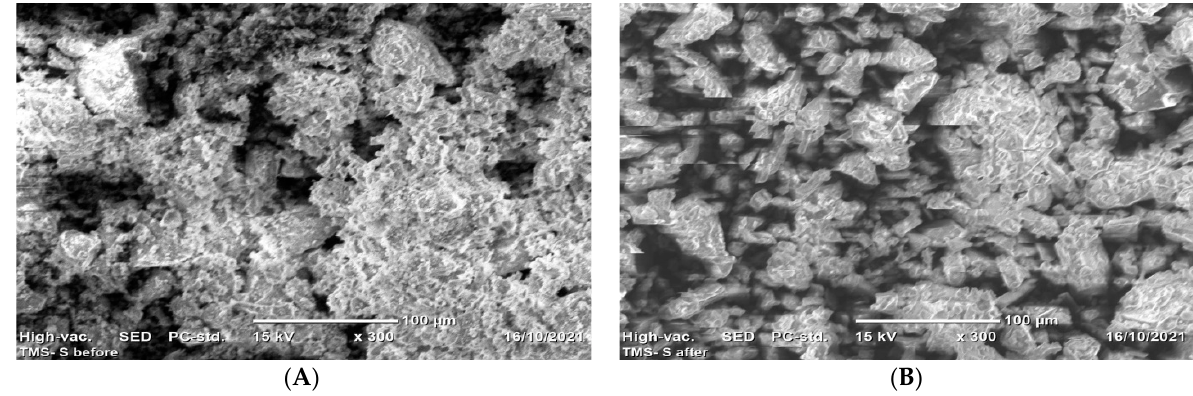
Figure 2. TMS’s surface morphology ( A ) prior to adsorption and ( B ) following adsorption.